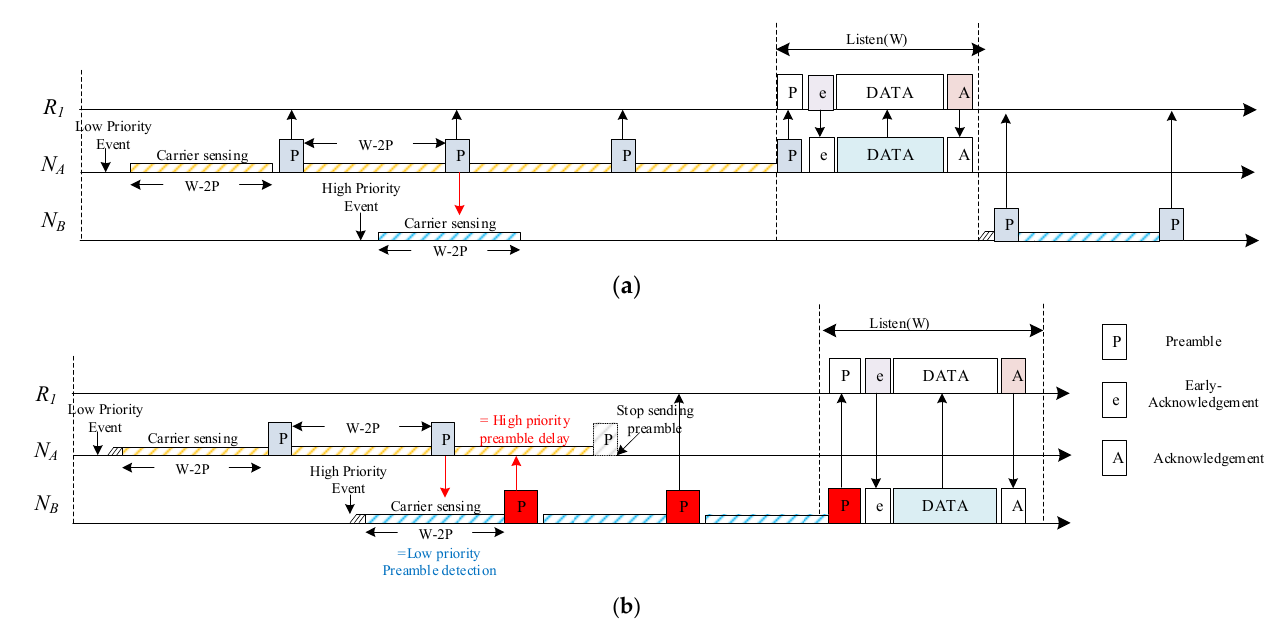
Figure 4. Duty-cycle-based protocol operation methods: ( a ) X-MAC Protocol; ( b ) Pre-emption MAC